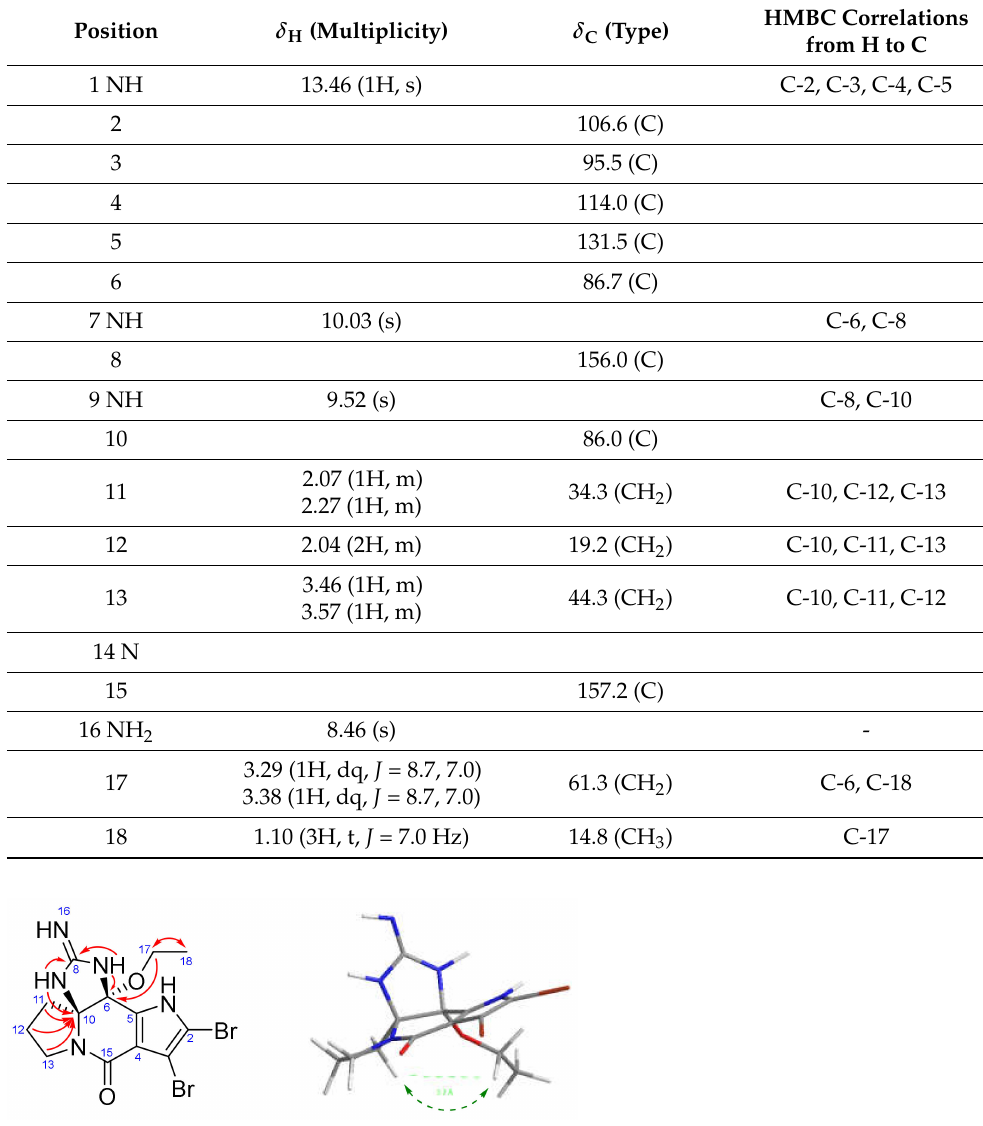
Table 1. 1 H NMR, 13 C NMR data, and HMBC correlation of rac -6- O Et-cylindradine A ( 1 ) in DMSO- d 6 .